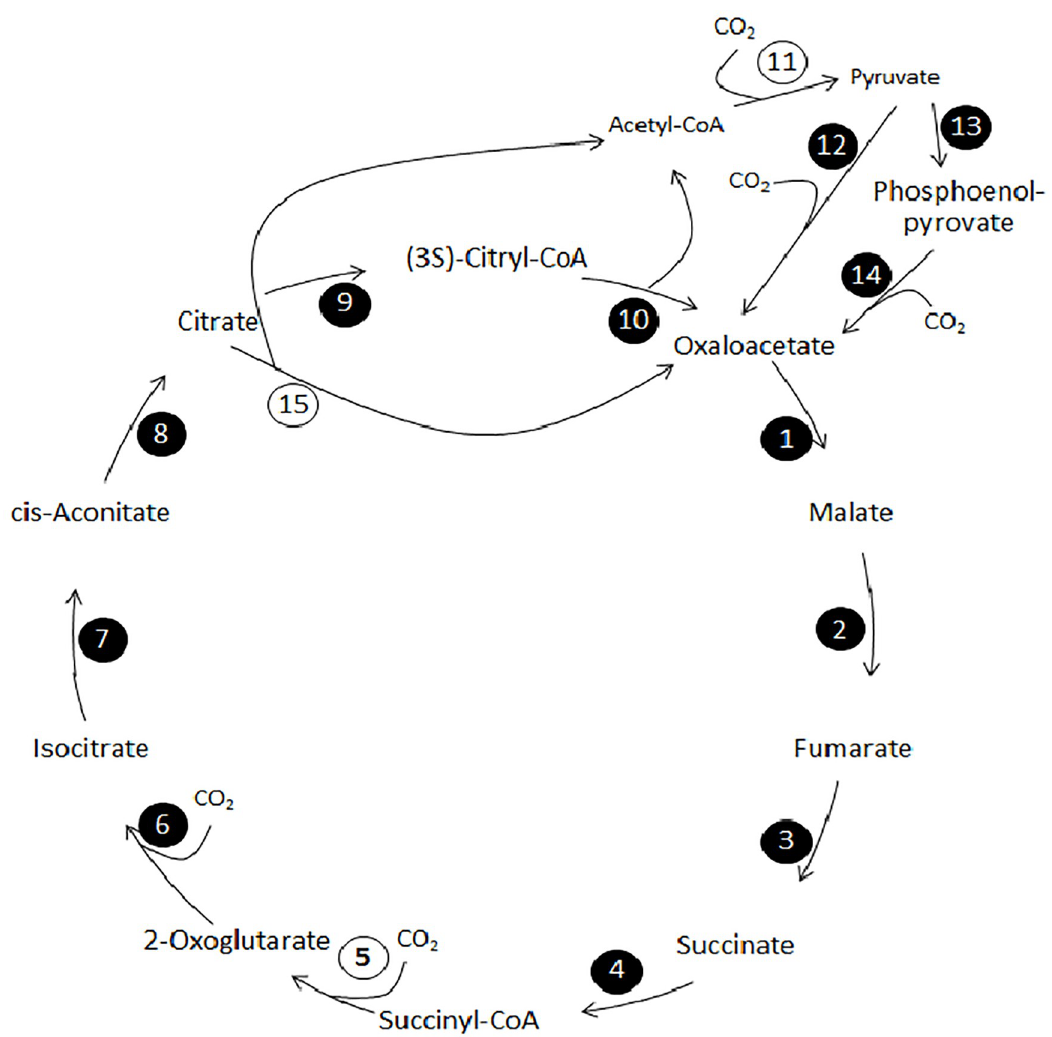
Fig 3. Schematic representation of rTCA modified from KEGG map; map00720. Reactions are coded by numbers in circles and described in Table 4. Critical reactions of the pathway i. e. those which are conducted by key enzymes are shown with numbers in white circles wherease others are circled in black. Comparison of the nessesary reactions of the pathway with those present in Salinibacter ruber DSM13855, suggests that this pathway can be present in Salinibacter ’s metabolism. When these reactions where included in the reconstructed model, FBA analysis showed that it can carry out fluxes under low nutrition conditions.